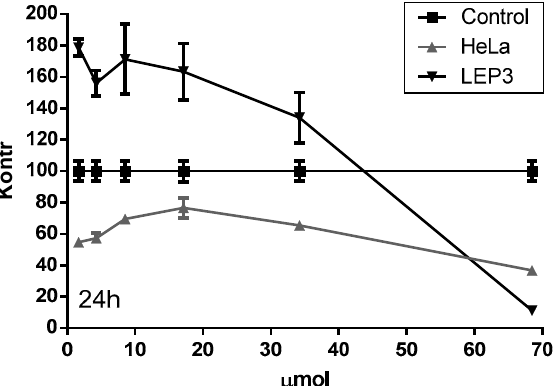
Figure 7. The effect of Zn 4 (D16)(NO 3 ) 8 ] on the viability and/or proliferation of tumor (HeLa) and non-tumor (Lep-3) cells after a 24-h treatment period.